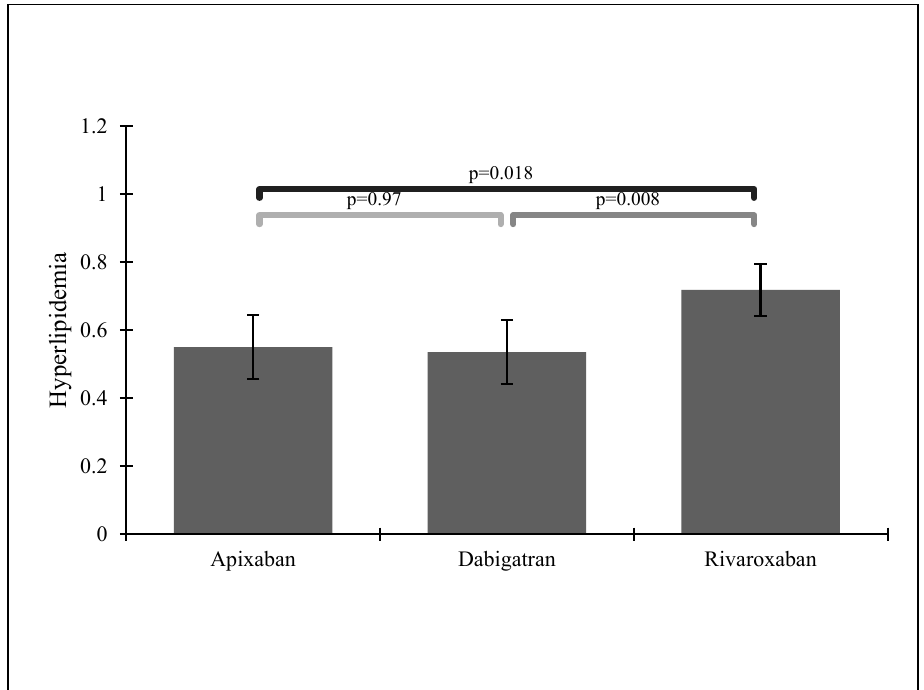
Figure 5. NOAC administration in patients with a previous stroke history and hyperlipidemia.